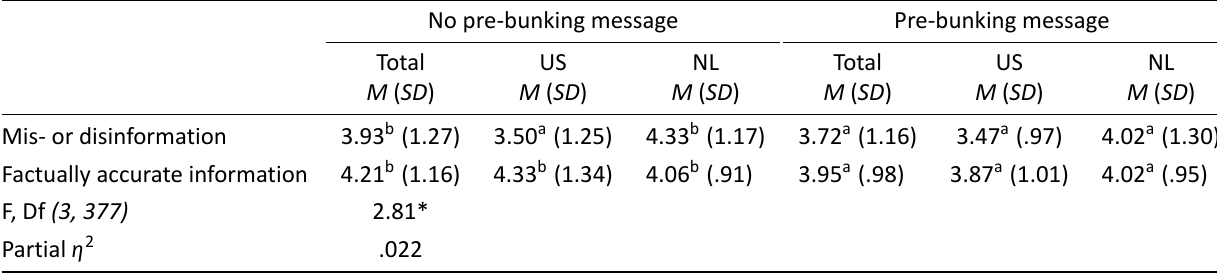
Table 1. Mean score differences across all four